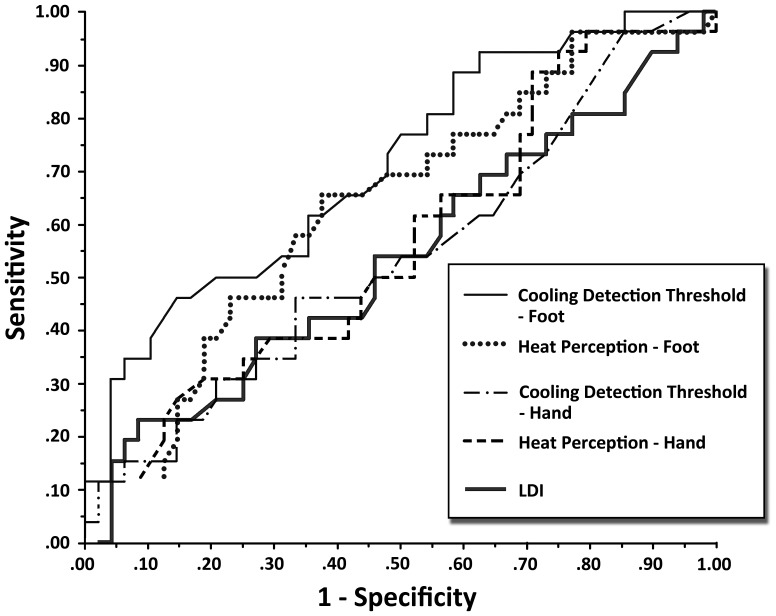
Shows the ROC curves for small fiber function tests of cooling detection thresholds and heat perception thresholds in upper and lower extremities and the laser Doppler flow studies in the foot.